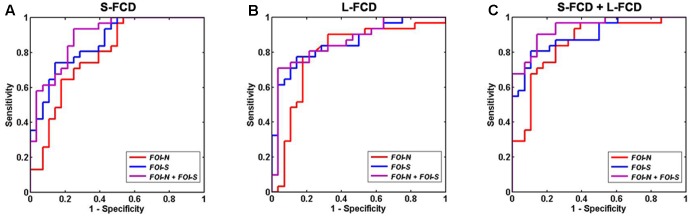
Receiver operating characteristic (ROC) of discriminating GAD patients from HCs by using FCD values in the significant group difference regions. (A) S-FCD values in the significantly different regions; (B) L-FCD values in the significantly different regions; (C) a combination of S-FCD and L-FCD values in the significantly different regions. In (A–C), red, blue, and purple line represent the FCD in FOI-N, FOI-S, and FOI-N+FOI-S, respectively.